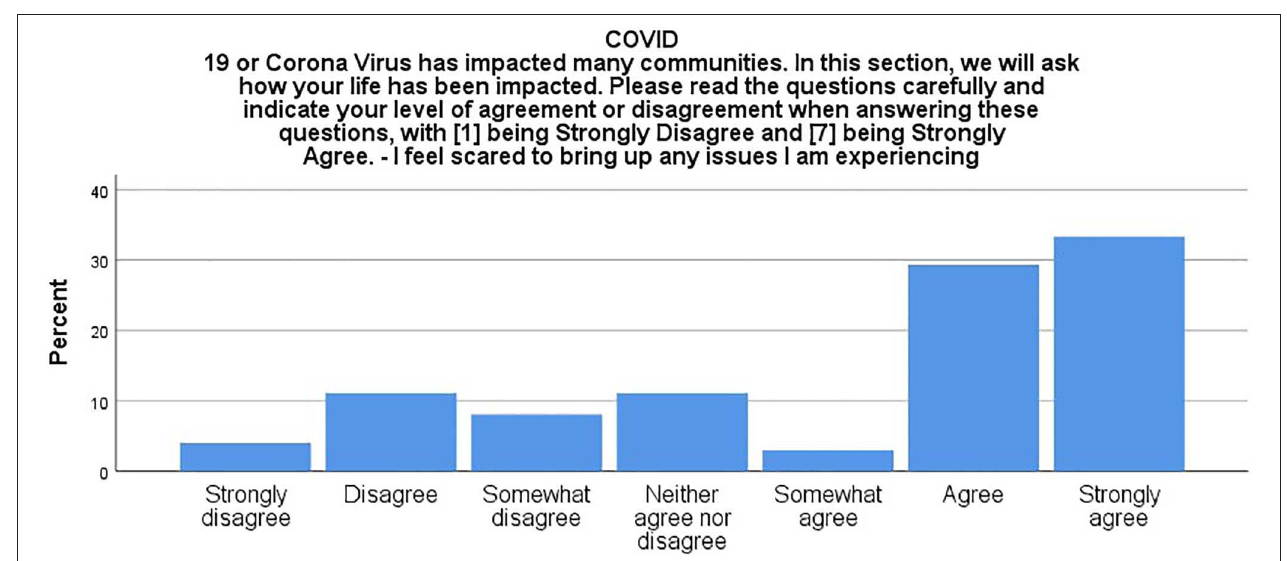
FIGURE 7 | Distribution of participants reporting fear in bringing up